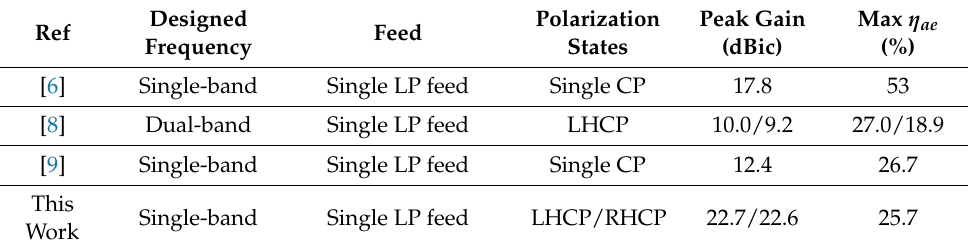
Table 1. Performance comparisons between Fp resonator antennas.